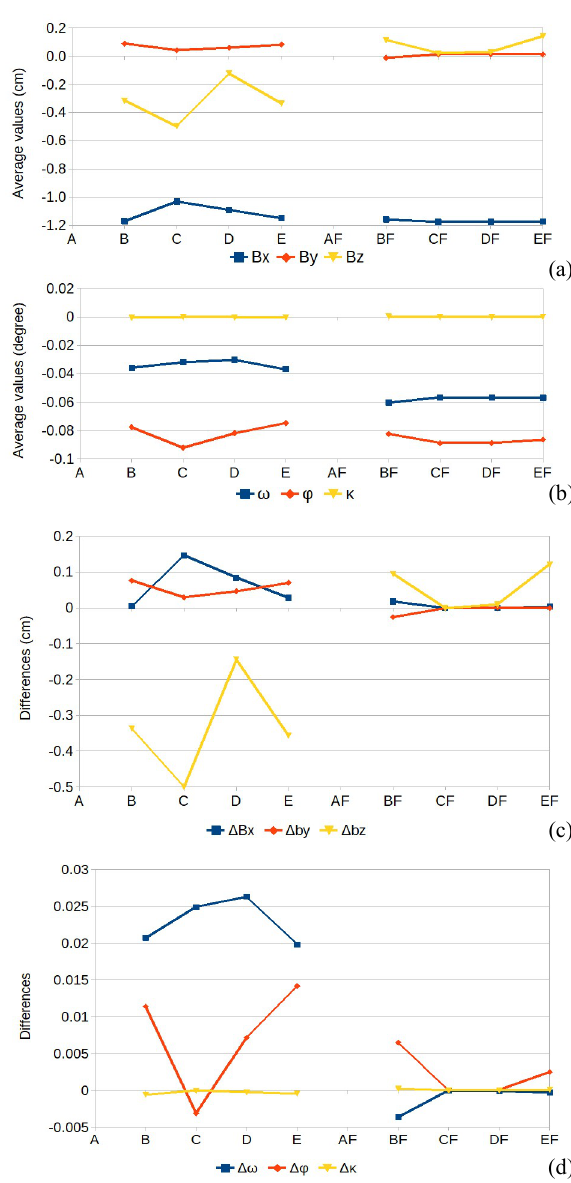
Figure 7. Estimated values of the relative orientation parameters (a) base components (b) rotations and, (c) and (d) differences with respect to CF values.